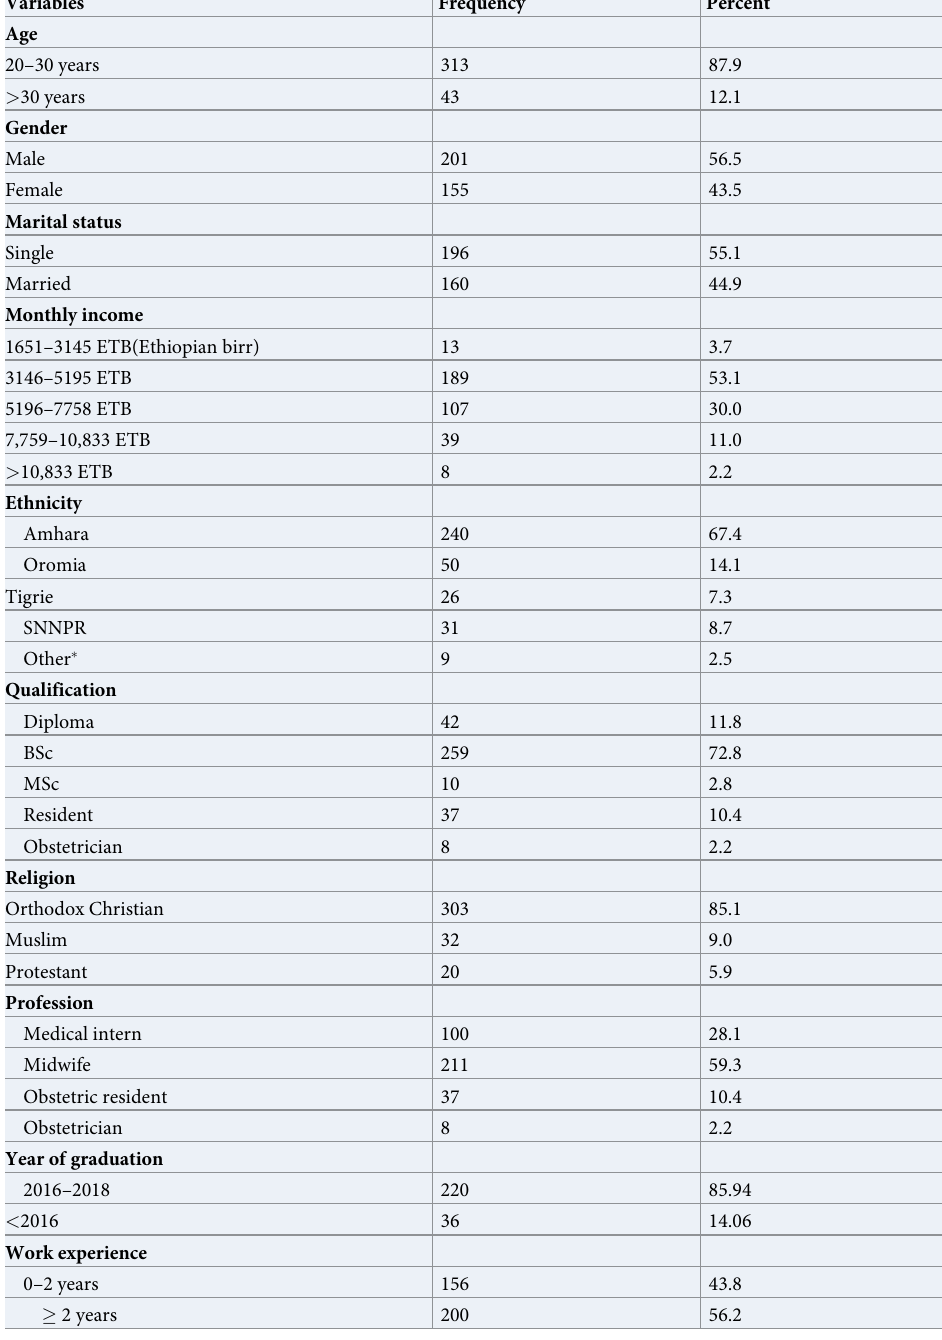
Table 1. Socio-demographic characteristic of